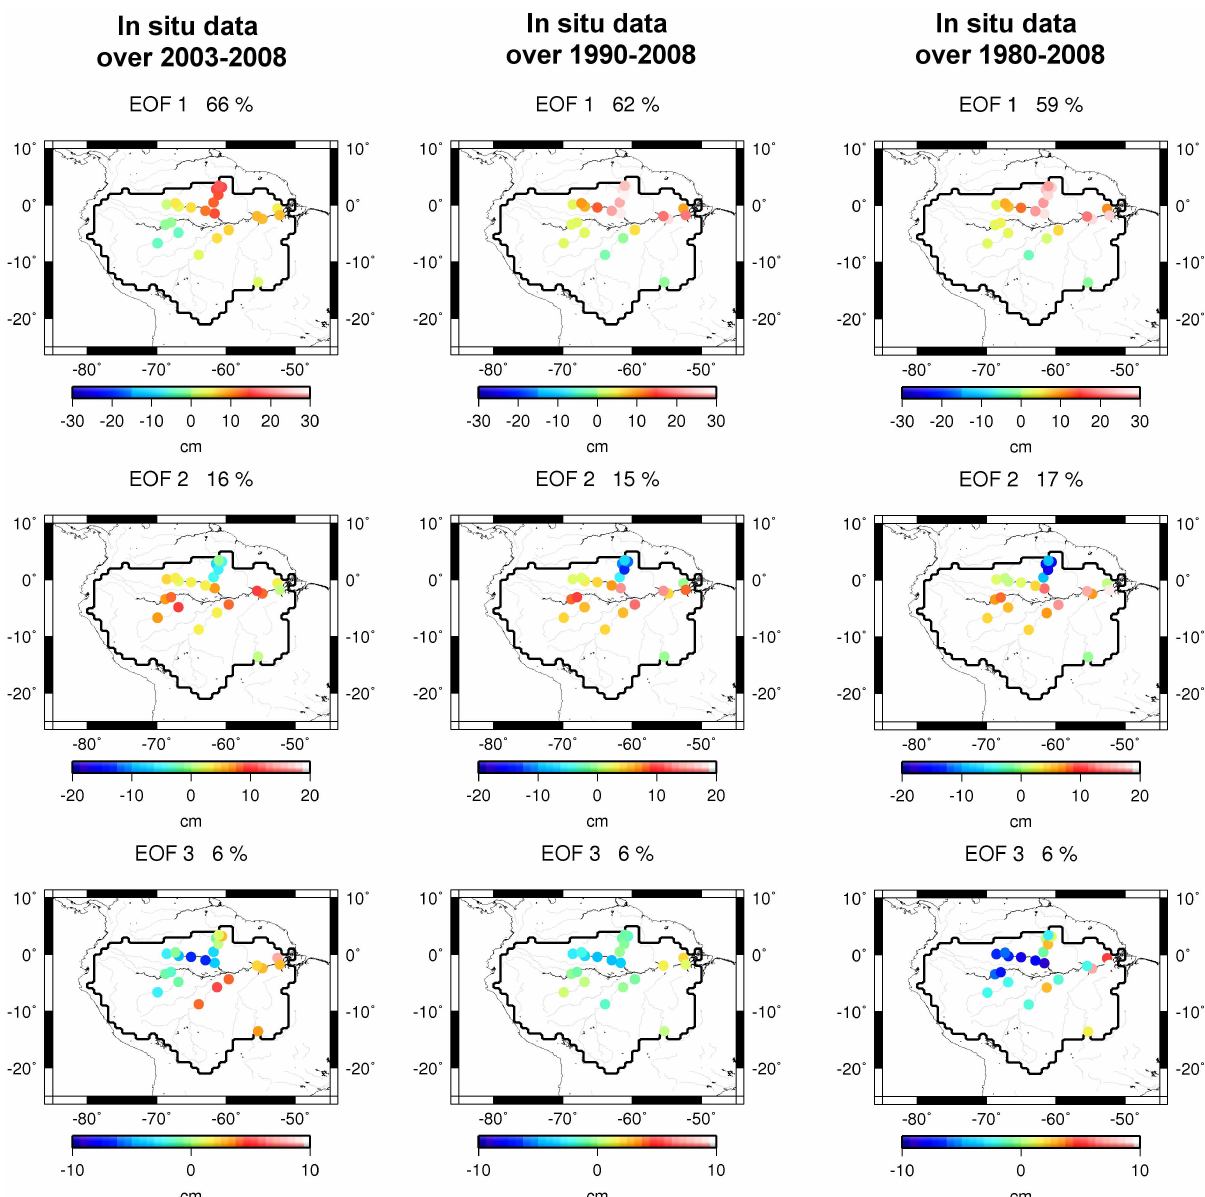
Fig. 4. Spatial patterns of the third EOFs computed from in situ gauges. The black dots correspond to the 23 in situ gauges (the same 23 used in the reconstruction) used for the EOF analysis over 2003–2008 (left panel), 1990–2008 (middle panel) and over 1980–2008 (right